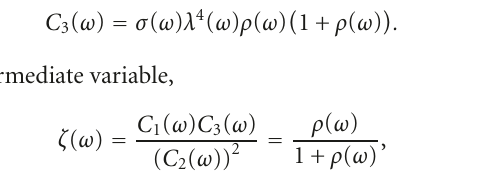
Figure 7: Arrival responses of the open cylinder at speaker (a) and open end (b), showing evenly spaced pulses as inverse transforms of combinations of transfer functions seen in Figure 5, with the addition of the open-end reflection R L ( ω ) (a) and transmission T L ( ω ) (b). Notice the alternating polarity (a) as compared to Figure 7, due to the negative reflection of an open